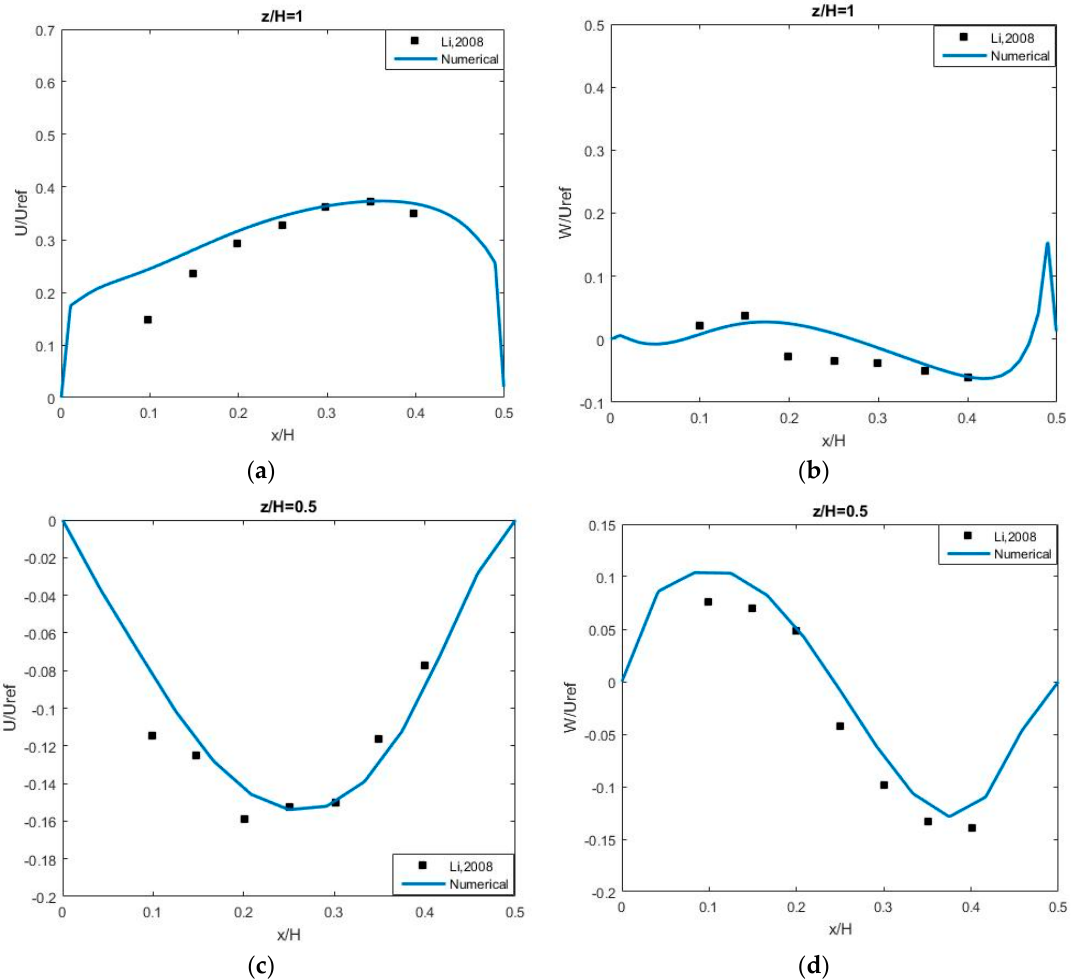
Figure 7. The horizontal profile of the normalized velocities U/Uref ( a , c ) and W/Uref ( b , d ) with AR = 2.